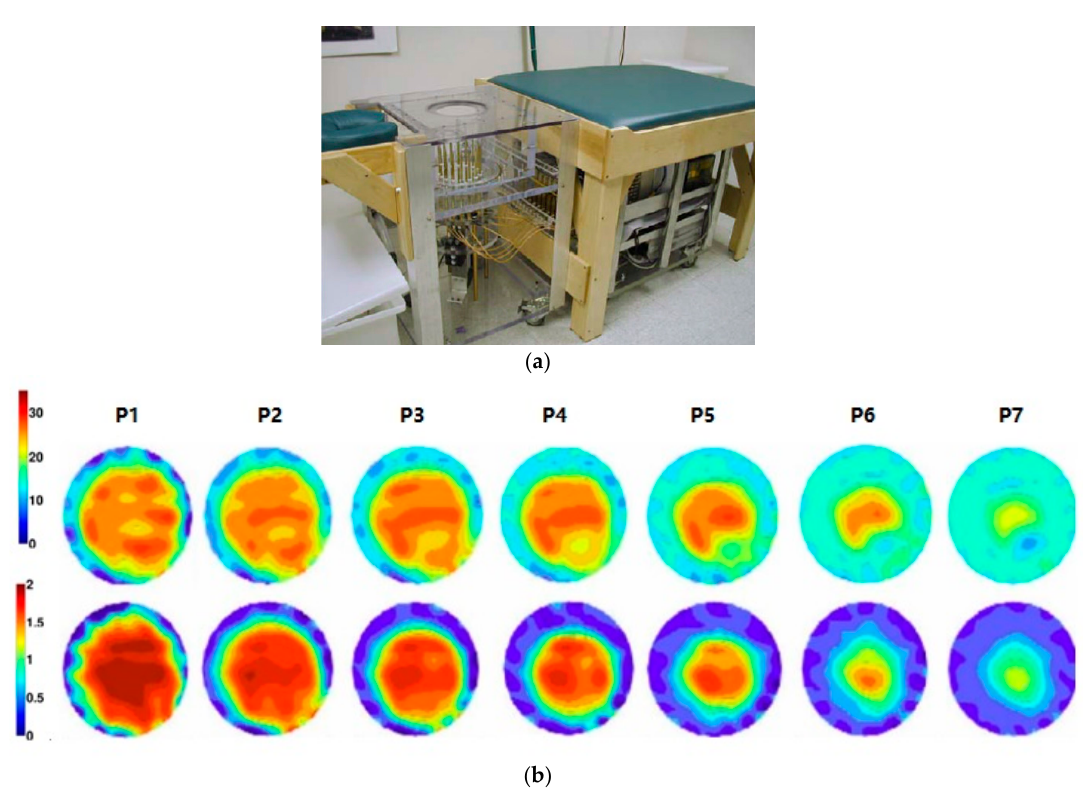
Figure 1. ( a ) Multi-frequency MWT prototype; ( b ) Reconstructed images of right breast at different frequencies (top row—permittivity and bottom row —conductivity)